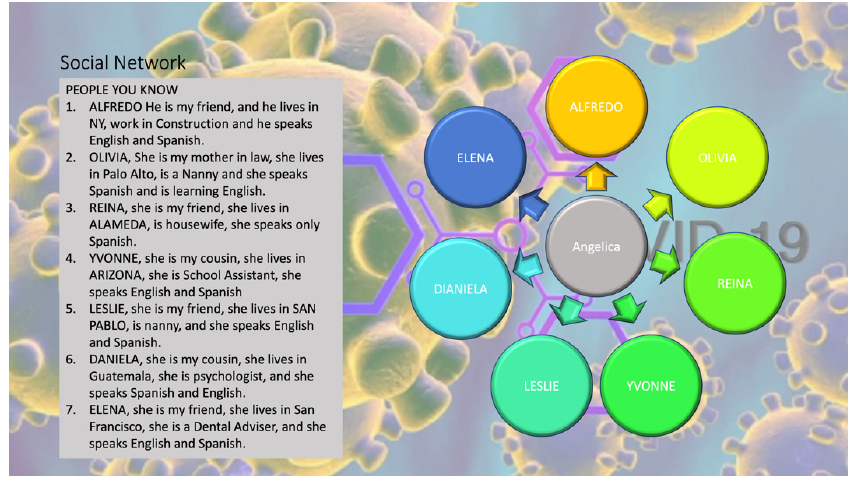
Figure 3. Depiction of a learner’s social network where the learner is not in the image, and people are grouped by their relationships with each other, with two (6 and 7) outside of the main cluster. Names have been changed to preserve confidentiality.